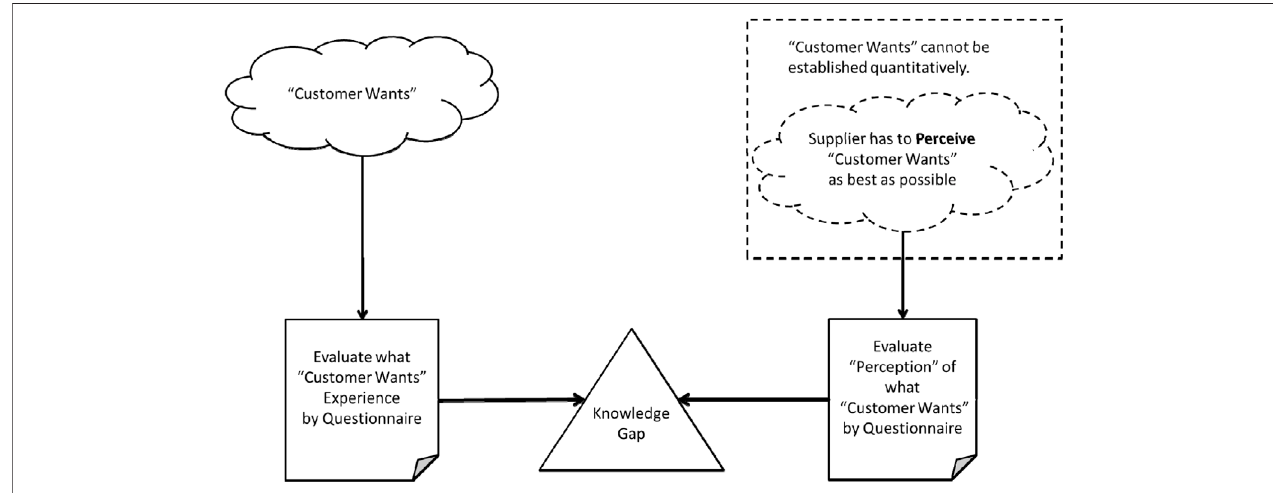
FIGURE 1 | Difference between customer experience and supplier perception.